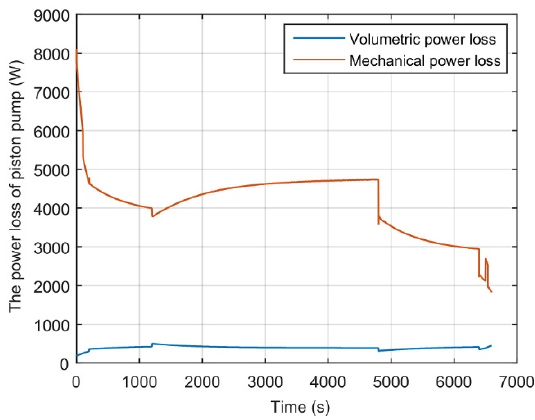
Figure 11. Power loss of piston pump.